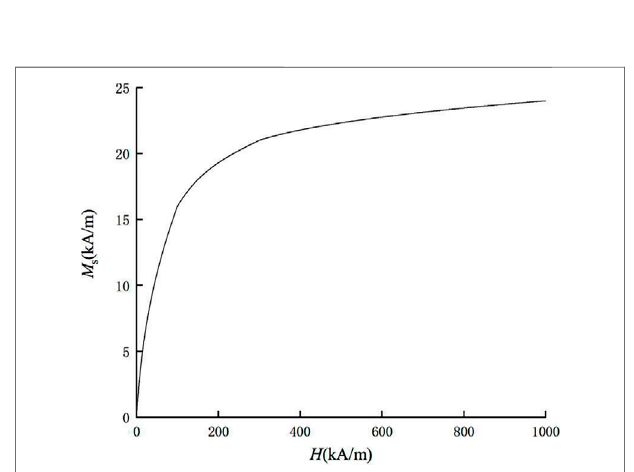
FIGURE 2 | Magnetization curve of the coal-based